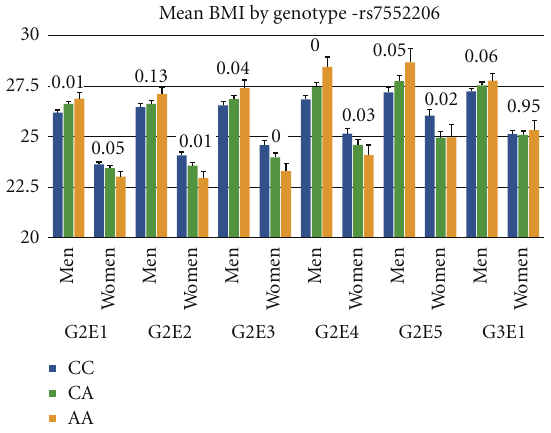
Figure 3: Mean body mass index (BMI) by genotype and sex across exams for the top associated SNP in LYPLAL1 (rs7552206) with Standard Error Bars and SNP P